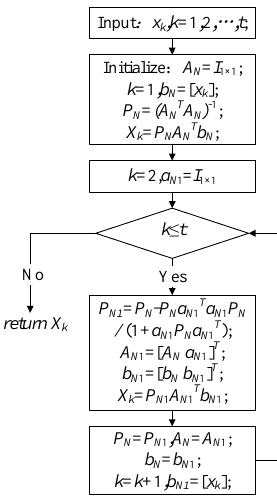
Figure 9. Flowchart of the RLS algorithm.